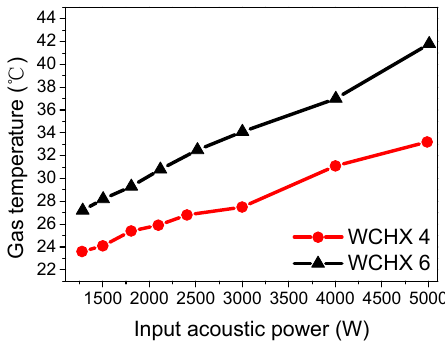
Figure 8. Temperature distribution in the regenerator at an input acoustic power of ( a ) 1270 W and ( b ) 5000 W, for WCHXs 4 and 6.